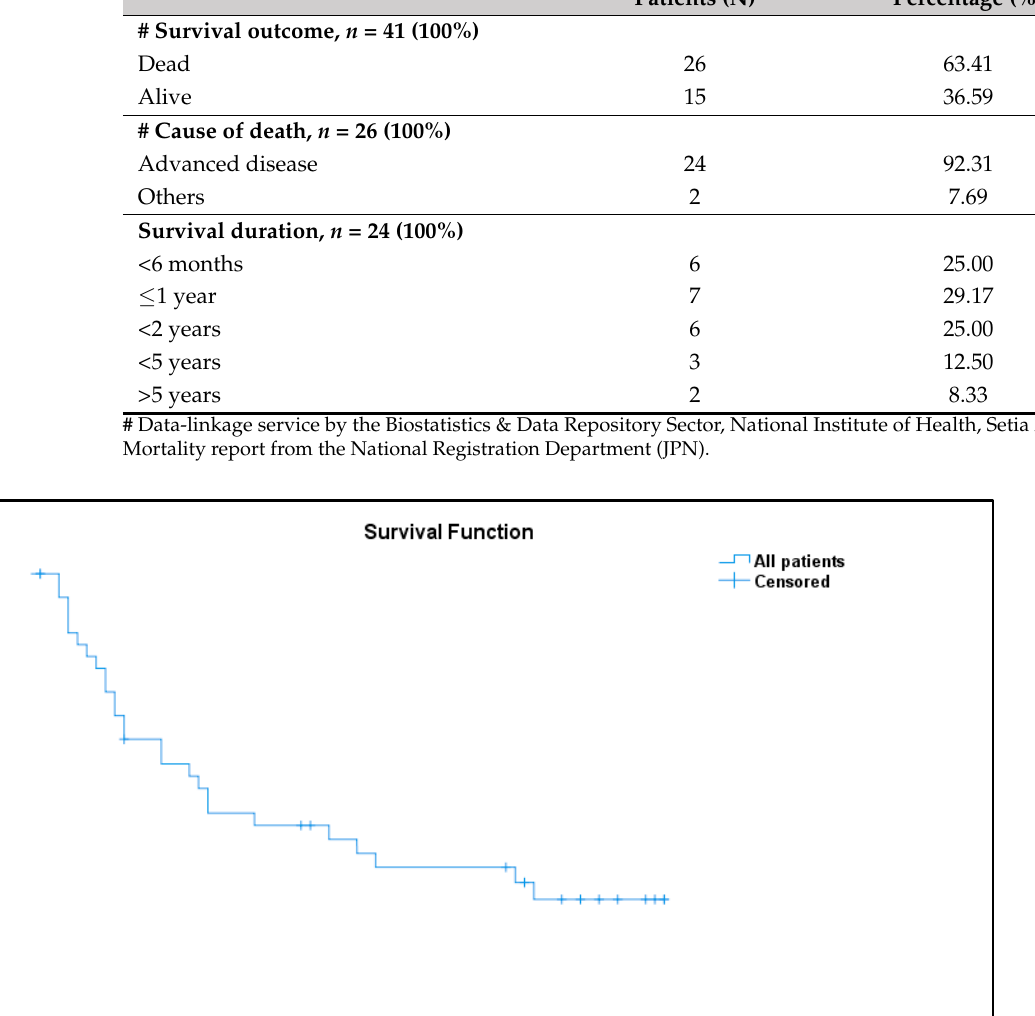
Table 7. Survival outcome of sarcoma patients.